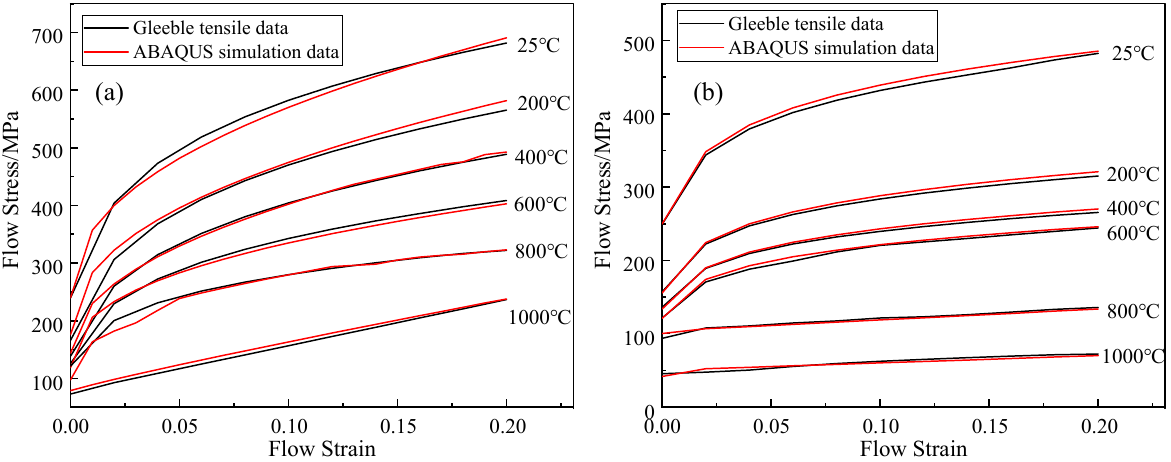
Figure 11. Q235B high temperature tensile test simulation cloud diagram.